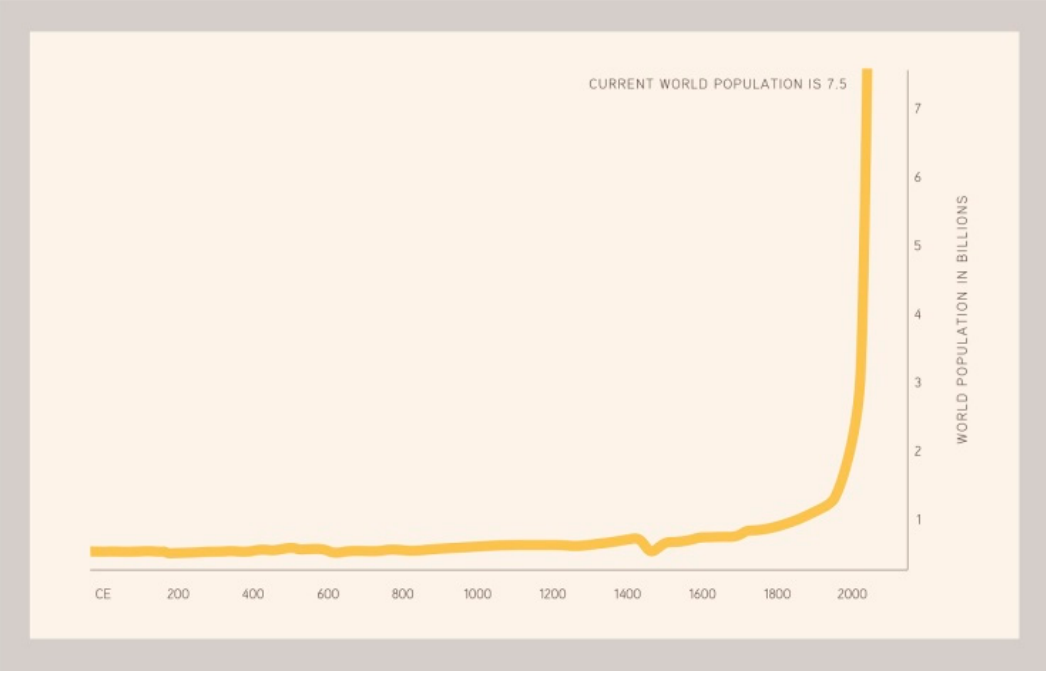
Figure 1. Changes in world population: From the beginning of the Common Era, the size of the human population grew gradually until about the 17th century and then with increasing speed through the 19th century. This gradual, but progressive acceleration was followed by a sudden steep rise in the 20th century—a consequence of the scientific, technological, industrial, and agricultural revolutions, which have had the effect of making it possible to sustain a human population far larger than ever before [7]. In the 1960’s, Salk reasoned that this growth without limit could not continue and that, barring collapse, the population curve might assume a sigmoid shape (Figure 2) [7], similar to that of Raymond Pearl’s classic experiment with fruit flies in a bottle [8–10].